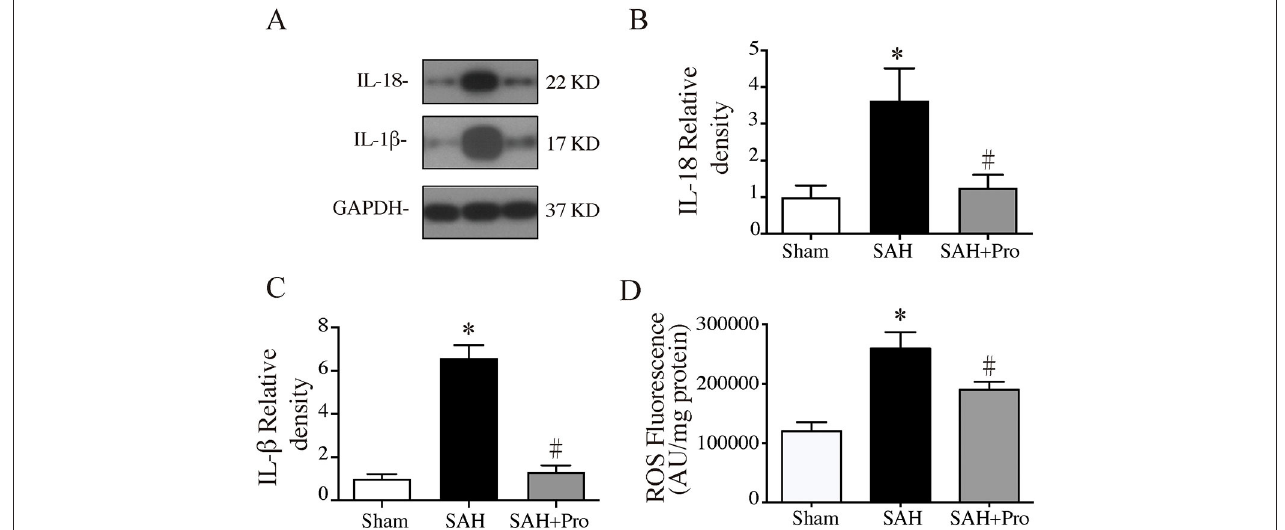
FIGURE 4 | (A) Representative western blotting images of interleukin-18 (IL-18) and interleukin-1 β (IL-1 β ). (B) IL-18 protein levels in sham, SAH, and SAH + pro groups, n = 6 each group. * p < 0.05 vs. sham group, # p < 0.05 vs. SAH group. (C) IL-1 β protein levels in sham, SAH, and SAH + pro group, n = 6 each group. * p < 0.05 vs. sham group, # p < 0.05 vs. SAH group. (D) The quantification of ROS levels in the ipsilateral basal cortex at 24h after SAH, n = 6 each group. * p < 0.05 vs. sham group, # p < 0.05 vs. SAH